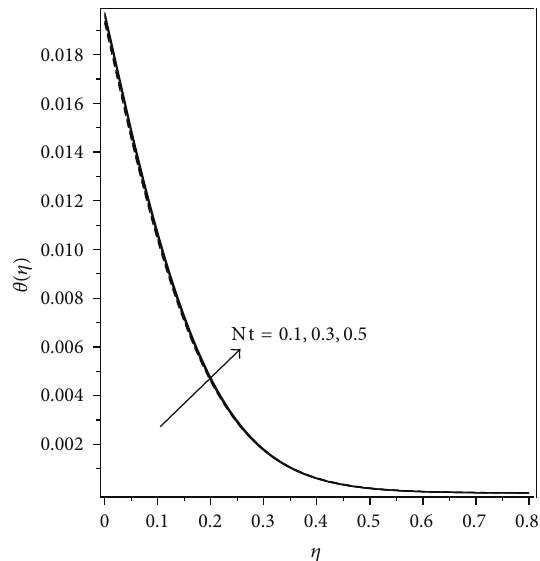
Figure 7: Variations of the local Sherwood number (concentration rates) with 𝜎 for different values of Nb when Nt = 0.5, Le = 2, Pr = 6.8, 𝛾 = 0.1, and S = 2.